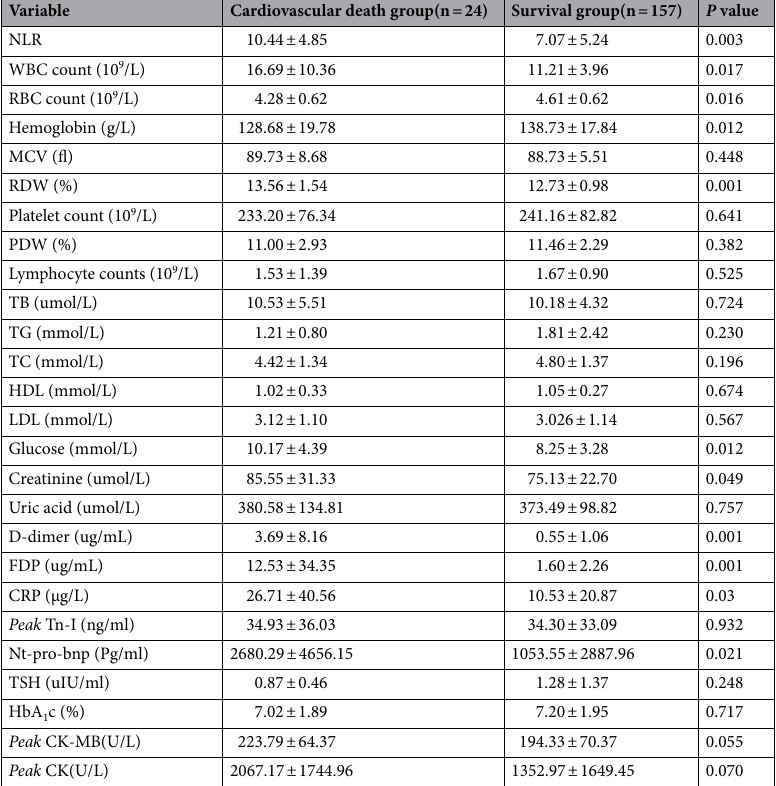
Table 2. Comparison of two groups of laboratory parameters. CK, Creatine Kinase; CK-MB, Creatine Kinase Isoenzyme-MB; CRP, C-reactive protein; FDP, fibrin degradation products; HbA 1 c, hemoglobin A 1 c; HDL-C, high-density lipoprotein cholesterol; LDL-C, low-density lipoprotein cholesterol; MCV, mean red blood cell volume; NLR, neutrophil to lymphocyte ratio; Nt-pro-BNP, N terminal pro B type natriuretic peptide; PDW, platelet volume distribution width; RBC, red blood cell; RDW, red cell distribution width; TB, total bilirubin; TC, total cholesterol; TG, triglyceride; Tn-I, Troponin I; TSH, thyroid stimulating hormone; WBC, white blood cell.